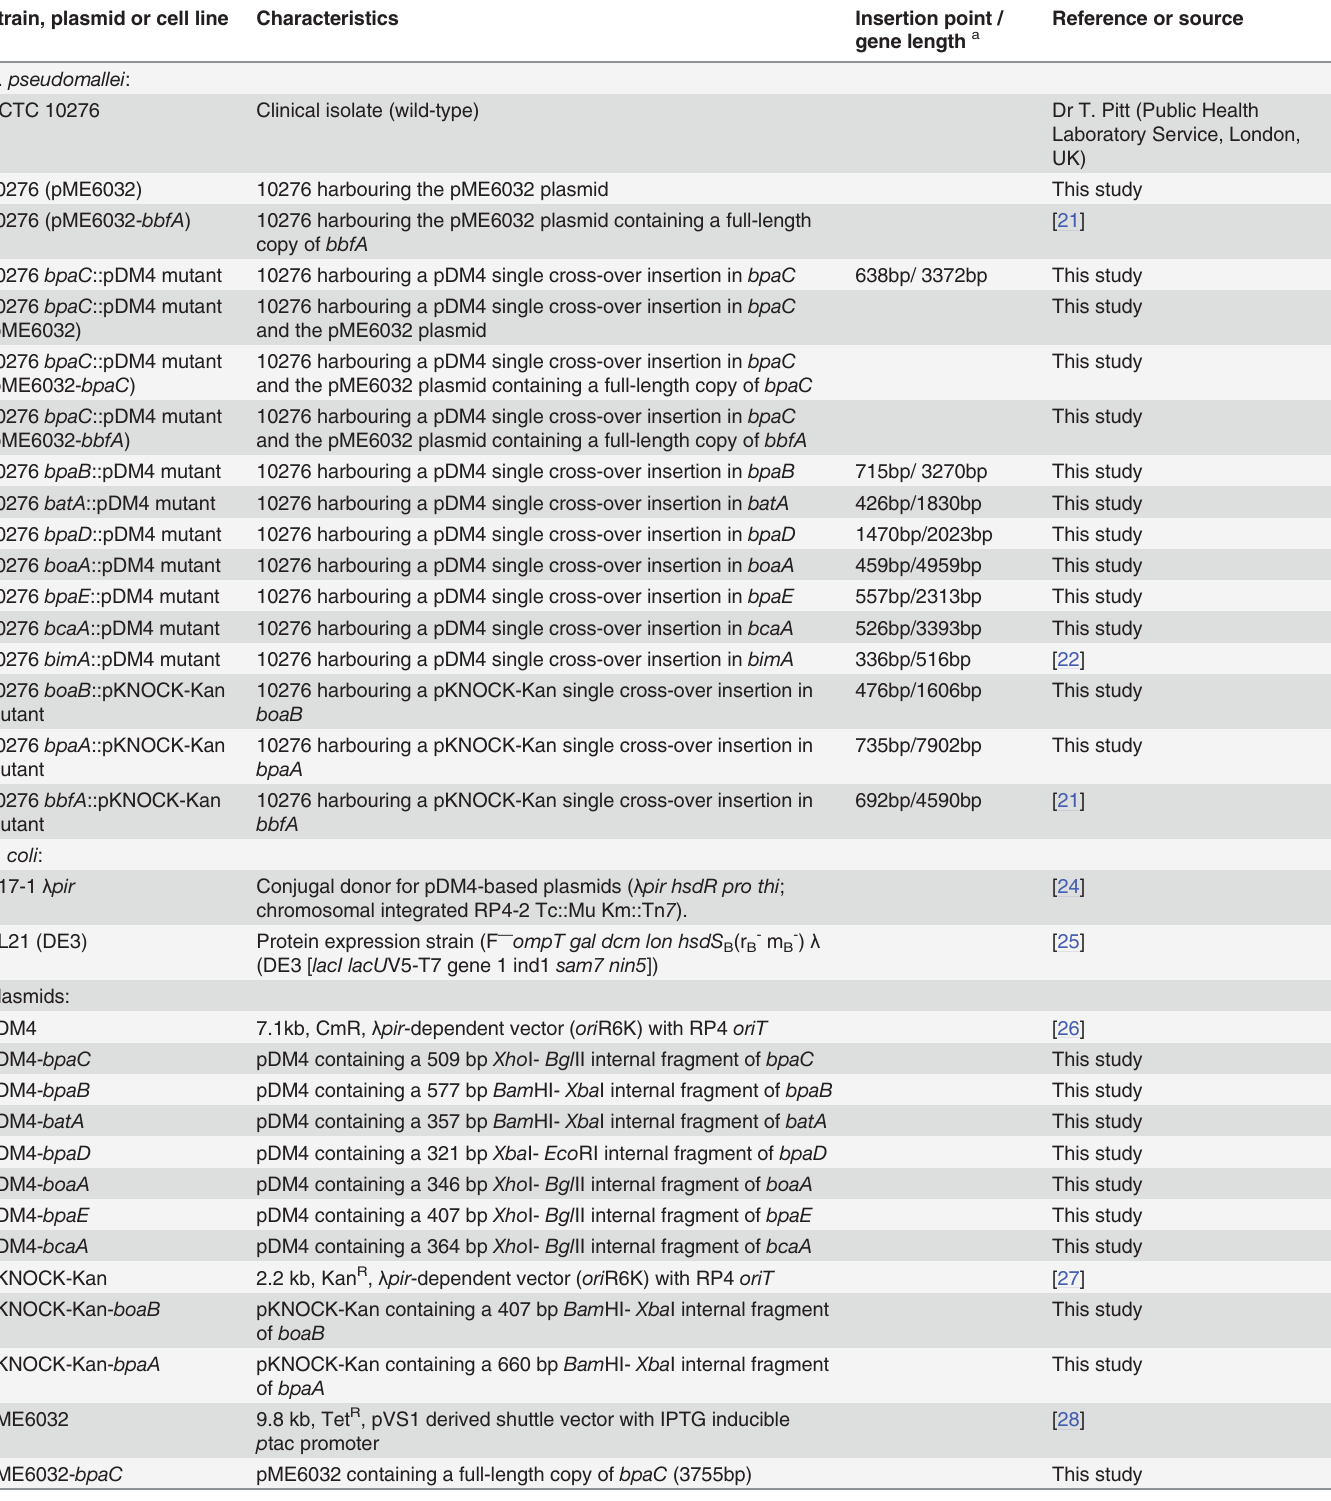
Table 2. Strains and plasmids used in this study. Strain, plasmid or cell